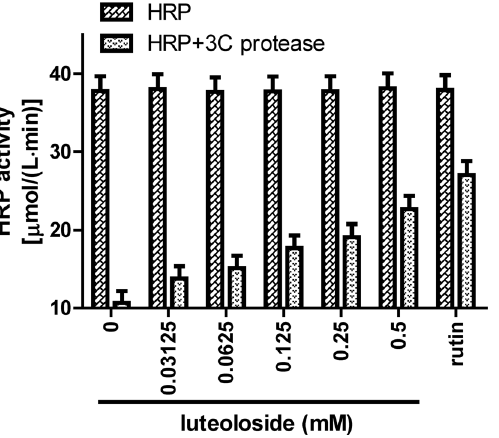
Fig 6. Dose-dependent inhibitory of luteoloside on EV71 3C protease activity in vitro . Two-fold dilutions of luteoloside were added in 3C protease analysis system. The enzymatic activity of HRP exposed to various treatments was calculated. Blank (0 mM luteoloside) and 0.5 mM rutin were set as negative and positive control, respectively. Data shown are the means ± SE values of 3 independent experiments ( n = 3).